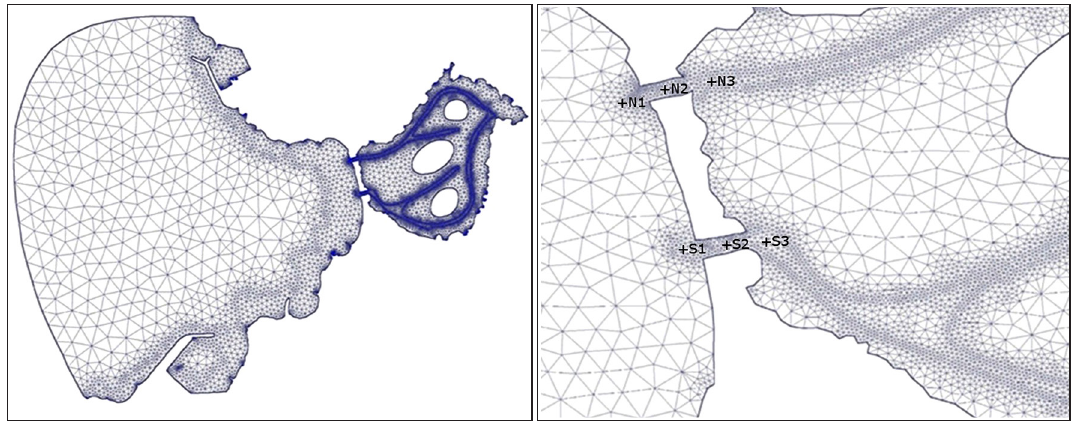
Figure 3. The computational finite element grid of the study area. The figure on the right zooms in to the inlet section of the lagoon to show detail. Locations of current recording stations (N1, N2, N3, S1, S2, S3) are also